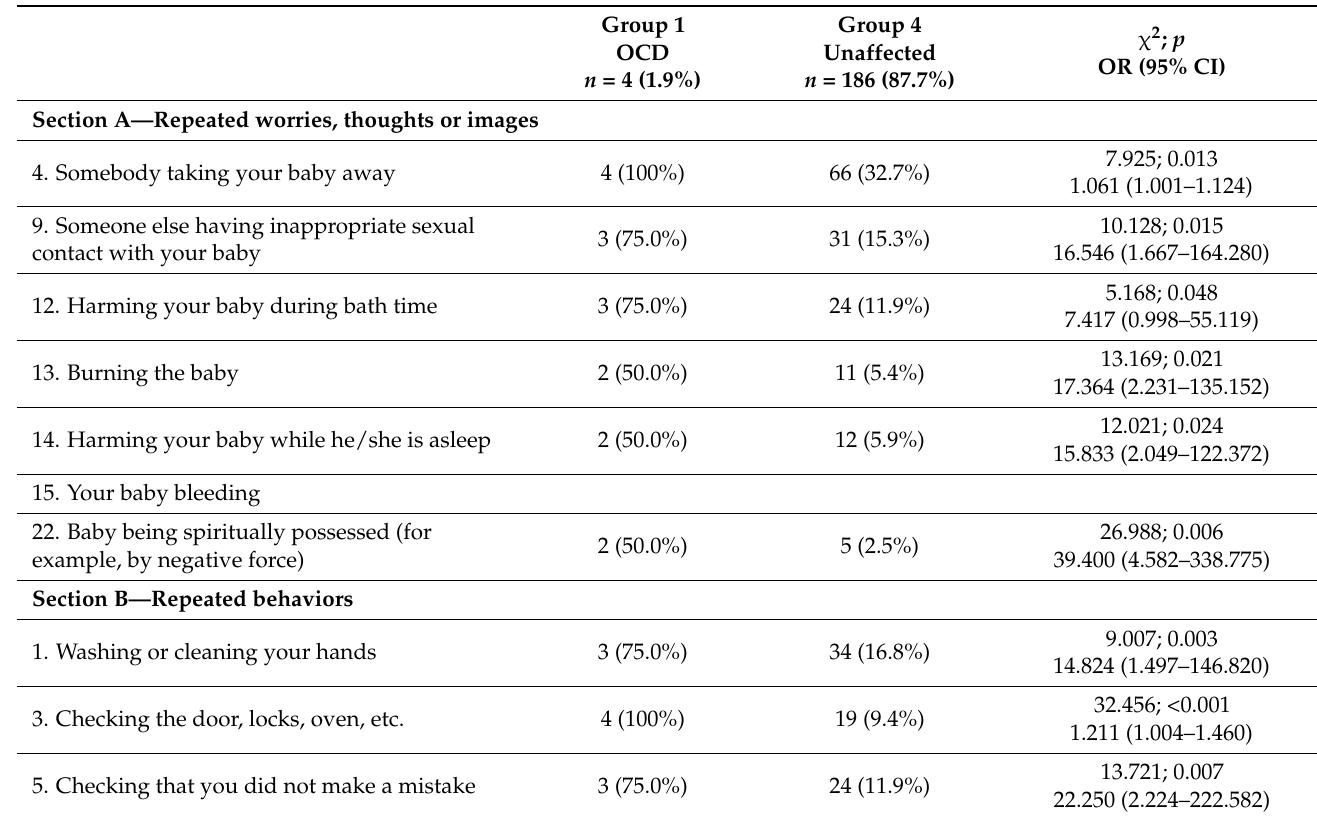
Table 4. Comparison of symptomatic answers between Group 1—With only OCD and 4— Unaffected/without any of these disorders—Chi-Squared